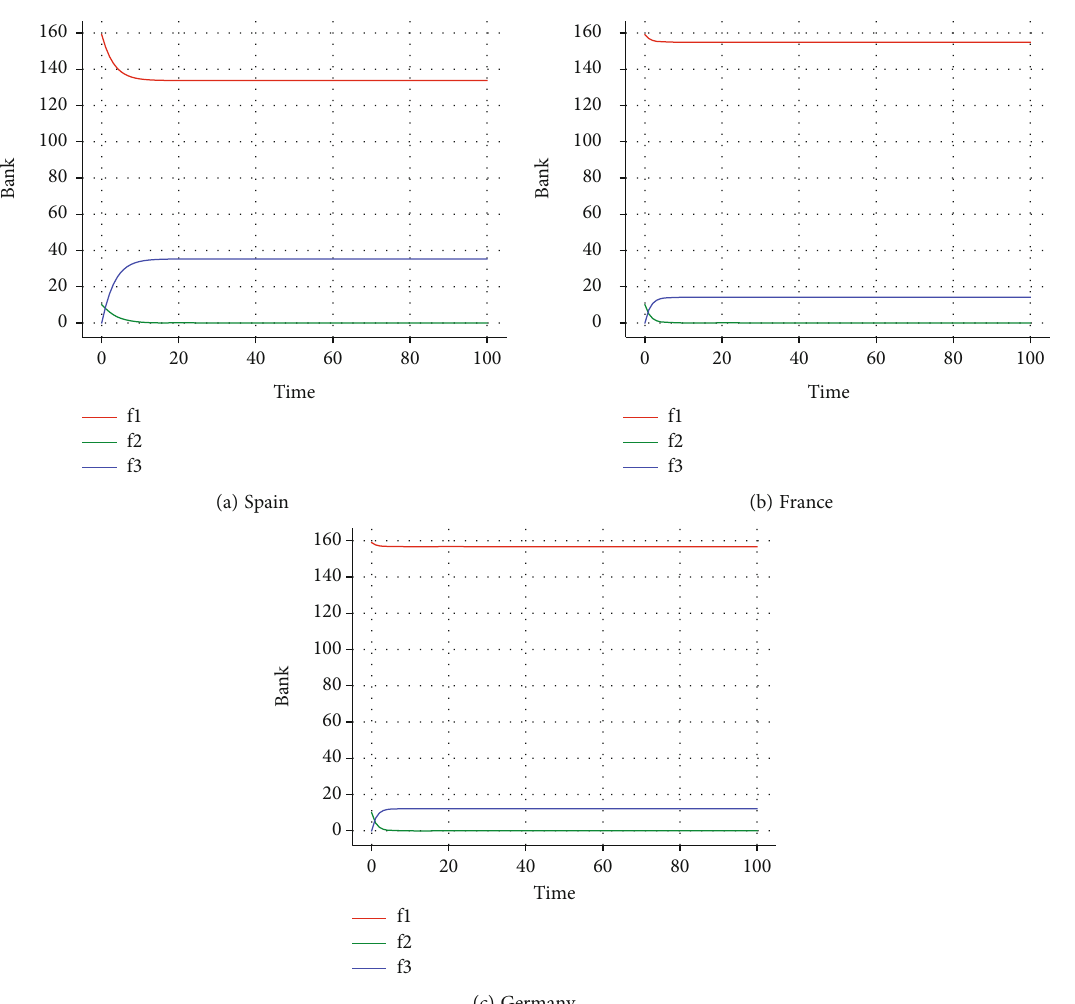
= 1 : 0 and t = 100 3